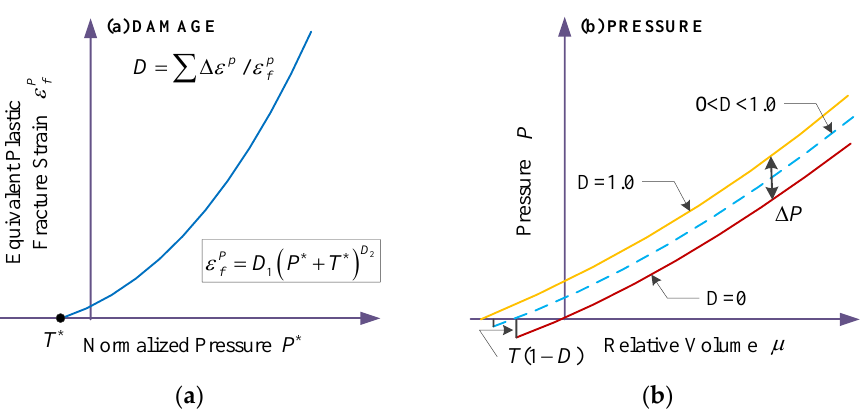
Figure 1. Strength model of the JH-2 constitutive model.